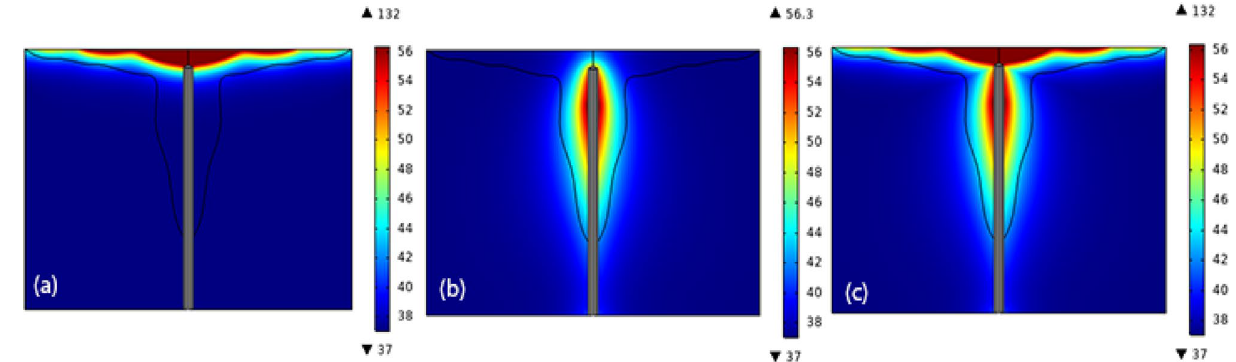
Figure 8. Temperature (degrees of Celsius) of the tumor in the presence of gold nanoparticles when ( a ) only pulsed laser is irradiated, ( b ) only microwave antenna is implemented, and ( c ) when both are